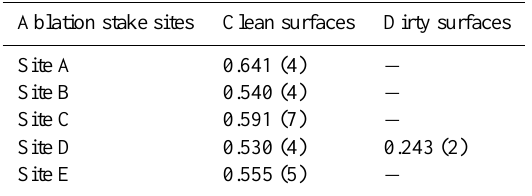
Table 2. Average broadband α ASD within a 30 m radius of ablation stake sites and classified by surface type. The number within the parenthesis denotes the sample size.